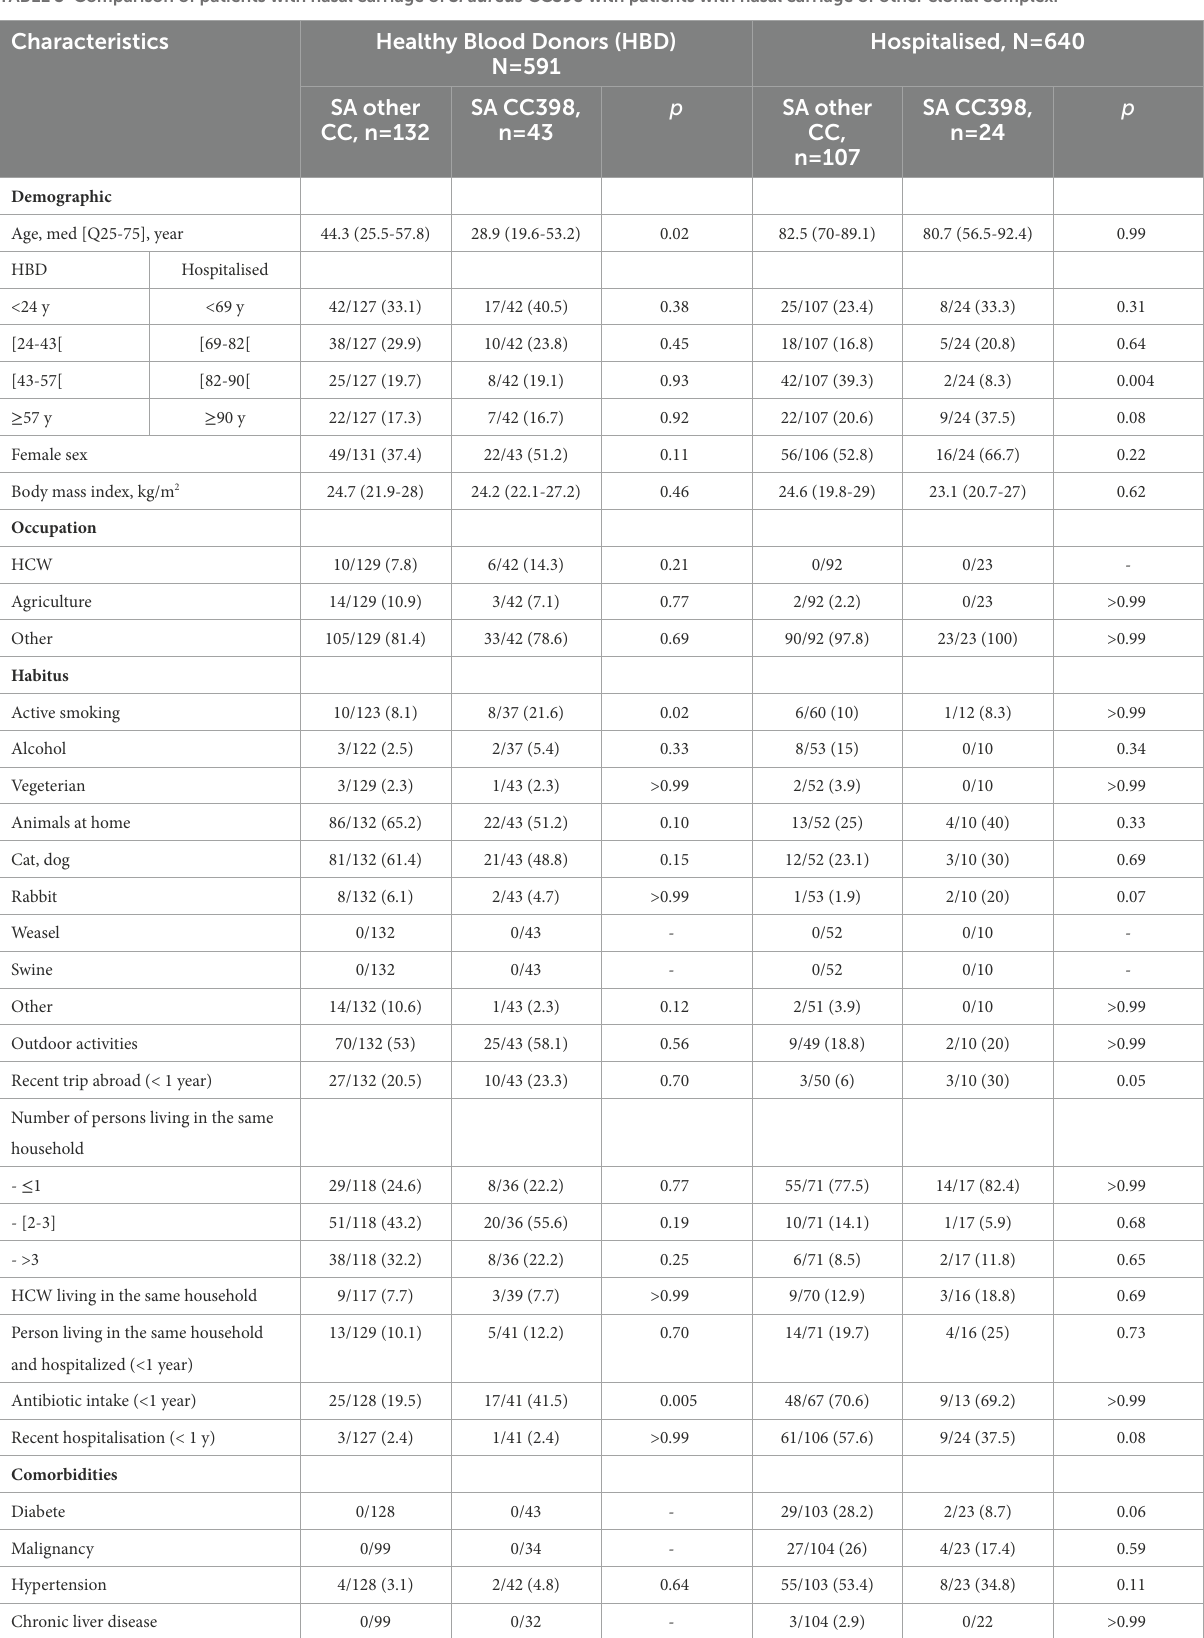
TABLE 3 Comparison of patients with nasal carriage of S. aureus CC398 with patients with nasal carriage of other clonal complex.